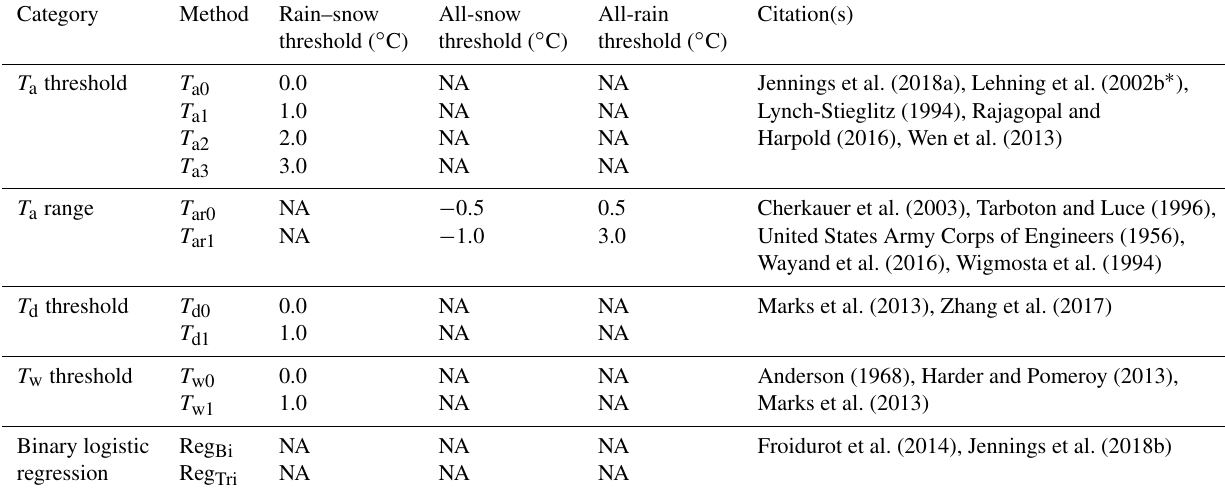
Table 2. Details on the precipitation phase methods used in this work. The temperature value for each threshold method is given in the “Rain–snow threshold” column. The “All-snow threshold” and “All-rain threshold” columns, respectively, give the T a values below which all precipitation is snow and above which all precipitation is rain for the T a range methods. The regression models compute phase as a function of meteorological conditions (Eqs. 1 and 2) during precipitation and are not associated with a threshold value. Due to a large variety of precipitation thresholds and ranges (Feiccabrino et al., 2015; Harpold et al., 2017b; Jennings et al., 2018b), the citations are listed if the values are approximate. NA: not